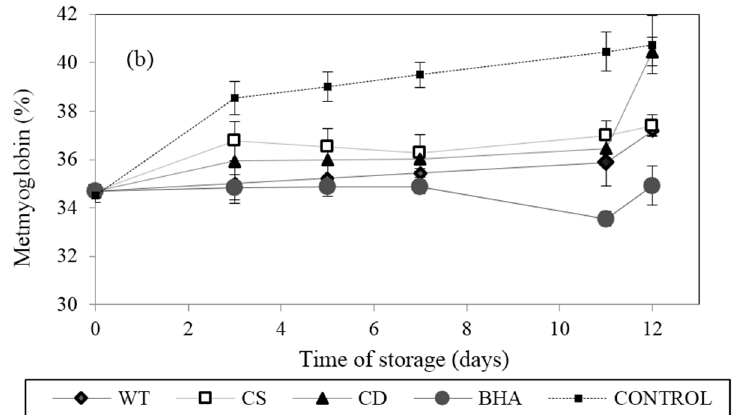
Figure 4. ( a ) Effects of films with CD and CS added at 1% and 0.2%, respectively, on the TBARS value (mg of malondialdehyde equivalent/kg of sample) of raw beef patties during 12 days of refrigerated storage at 4 °C and ( b ) effects of CD and CS extract added on metmyoglobin changes in beef patties during 12 days of refrigerated storage at 4 °C. Results are given as the mean ± standard error.